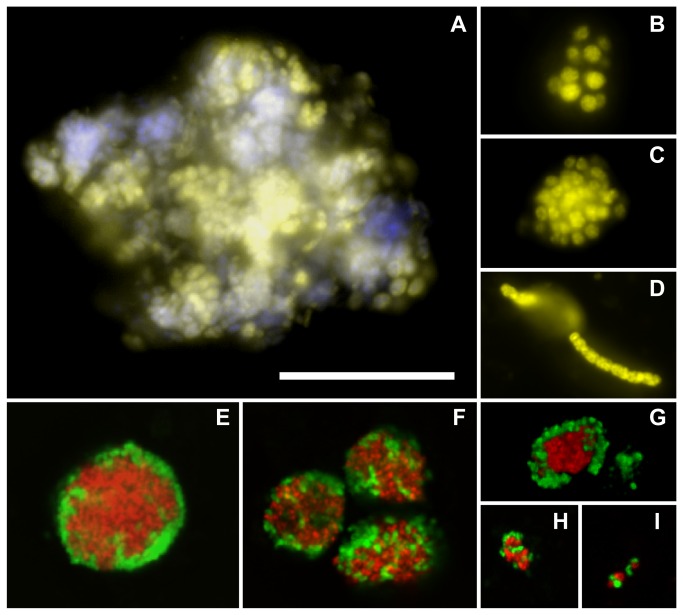
Micrographs of methylotrophic and methanotrophic organisms in sediments of Hikurangi margin seeps.
A–D: Aerobic methylotrophic organisms of the order Methylococcales (probe MTMC-701 - yellow) in surface sediment of the ampharetid site 309. The dual stain with probe and DAPI (blue) shows that the large aggregates contained other cells besides Methylococcales. E–I: Consortia of anaerobic methanotrophic archaea of the clade ANME-2a and ANME2c (probe ANME2a-647, ANME2c-760 - red) and sulfate-reducing Desulfosarcina/Desulfococcus (DSS) (probe DSS658 - green) in the deeper sediment layers. E,F: Shell-type and mixed-type ANME-2a/DSS consortia at the SOB site 315. G,H: Consortia of ANME-2a and the DSS subgroup SEEP-SRB-1a (probe SEEP1a-473 – green) at the ampharetid site 124. I: ANME-2c/SEEP-SRB-1a consortium at ampharetid site 124. The scale bar represents 20 µm.